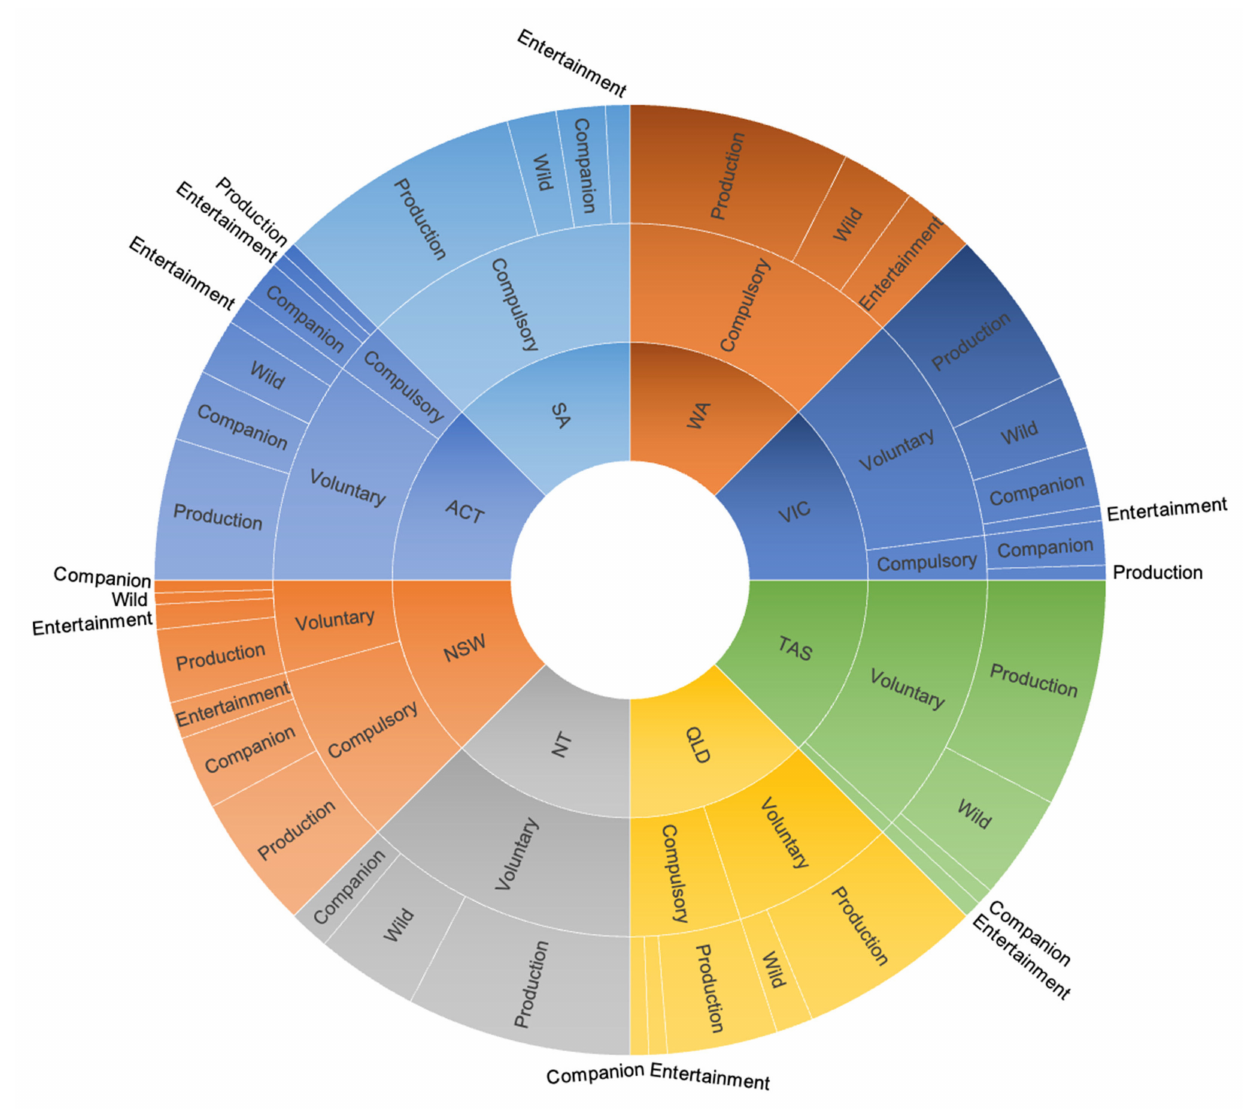
Figure 2. Sunburst diagram of the relative number of compulsory and voluntary codes per each Aus- tralian jurisdiction, per utility group. Each color represents a different jurisdiction, with the number of compulsory and voluntary codes prescribed under animal welfare statutes in that jurisdiction. This is broken down further to show use of compulsory or voluntary codes across each animal utility group (companion, production, wild and